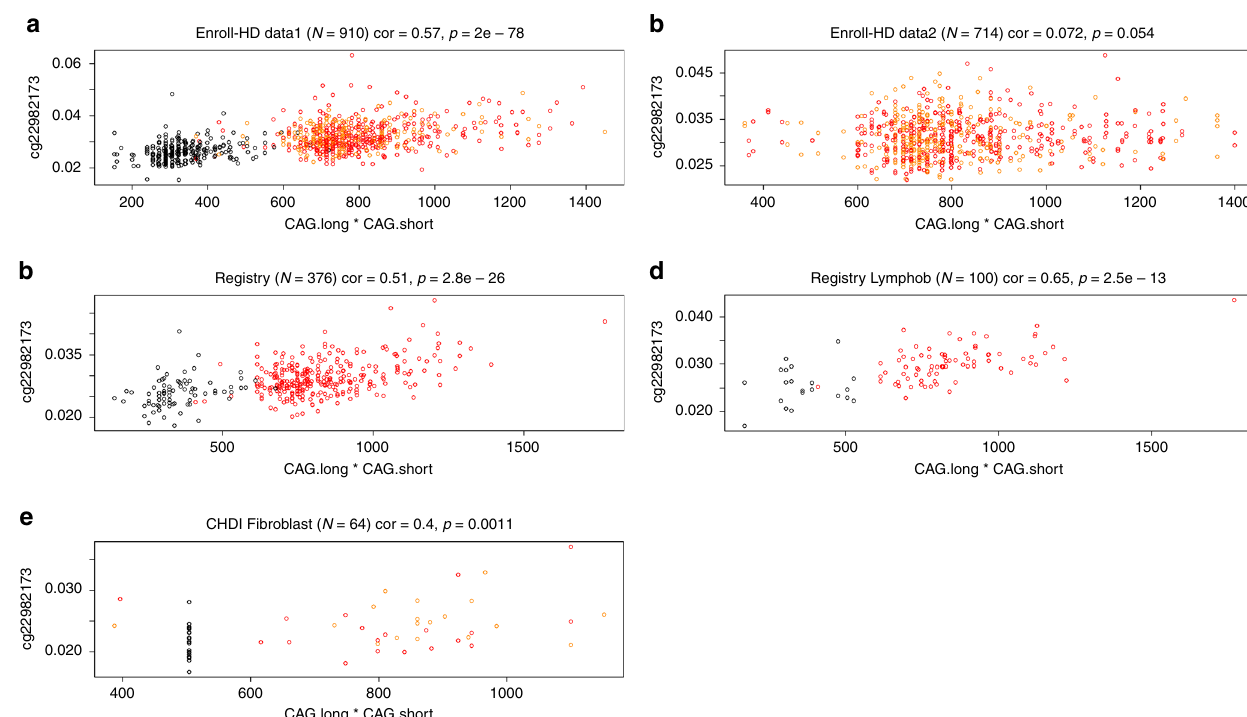
Fig. 6 Human HTT methylation versus the product of CAG lengths. The product of the two CAG alleles (CAG.product = CAG.long × CAG.short) correlated with DNA methylation levels of the human HTT cg22982173 locus in a blood samples from Enroll-HD data 1, b blood samples from Enroll-HD data 2, c blood samples from the Registry-HD study, d lymphoblastoid lines from the Registry-HD study, and e fi broblast samples from the MTM study. The title of each panel reports the Pearson ’ s correlation coef fi cient and corresponding unadjusted p value. Fixed-effects meta-analysis (weighted by inverse variance) produced a meta-analysis p value of 9.1 × 10 − 123 . Points in the scatter plots are colored by HD status: red = manifest HD, orange = pre-manifest HD, and black = control. Each plot reports a Pearson ’ s correlation coef fi cient and corresponding p overlap between the top 1000 hypermethylated CpGs and RNA